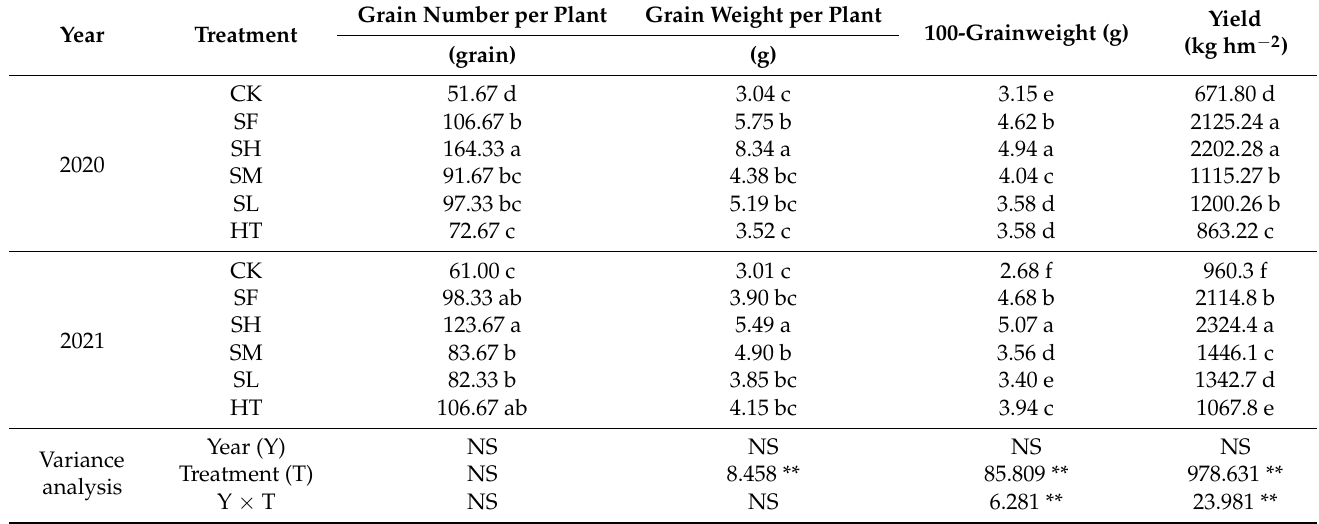
Table 7. Effect of rice straw combined with inorganic fertilizer on the yield of common buckwheat.